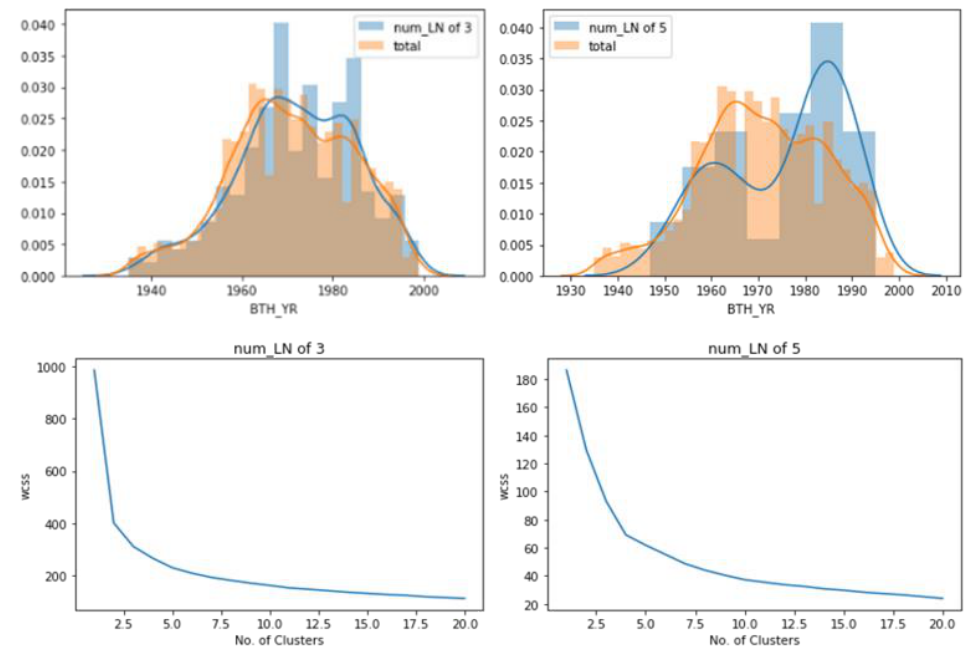
Figure 2. Multimodal distribution of the Birth Year of the group with three loans and five loans. The predicted number of clusters show the distinct distribution of the two groups.